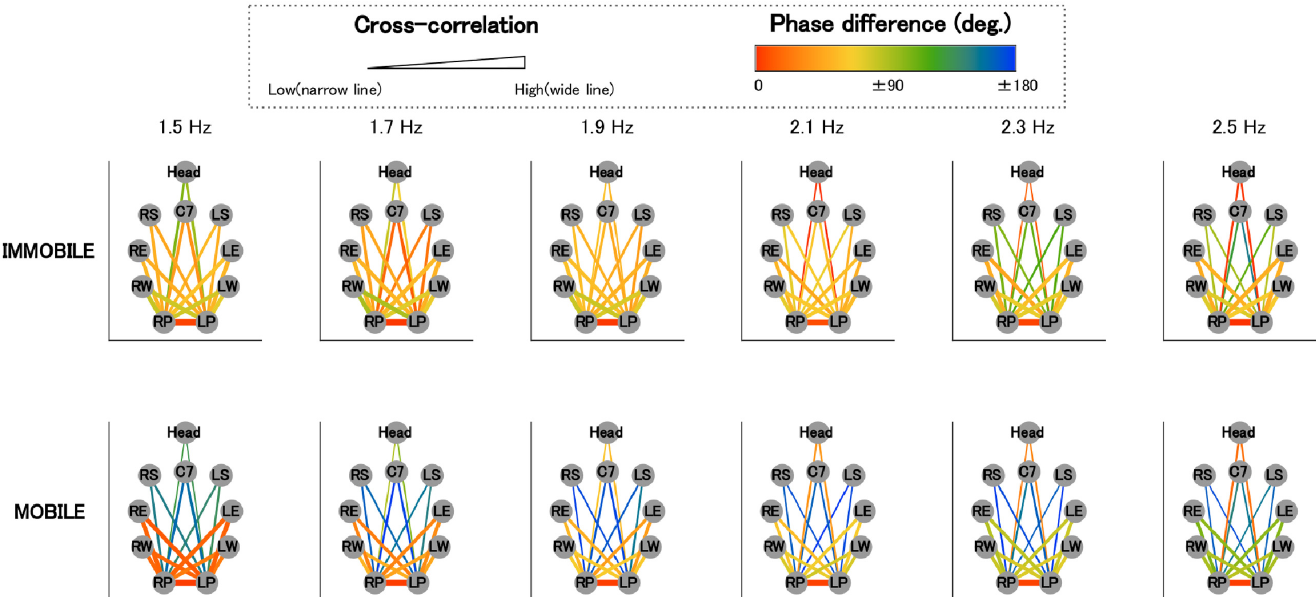
Fig 2. Visualization of the global coordinative structure (in-phase) ( N =18). This shows the global coordinative structure ( N =18). Mean first peak values of the cross- correlation and phase difference between the time series of anterior-posterior motion of the pendulum and each body are shown as lines projected onto the topologically arranged body parts (gray circles). The degree of cross-correlation is expressed by the thickness of the line and the phase difference by color gradients. RP represents the R-pendulum, LP L-pendulum, RW R-wrist, LW L-wrist, RE R-elbow, LE L-elbow, RS R-shoulder, and LS L-shoulder.